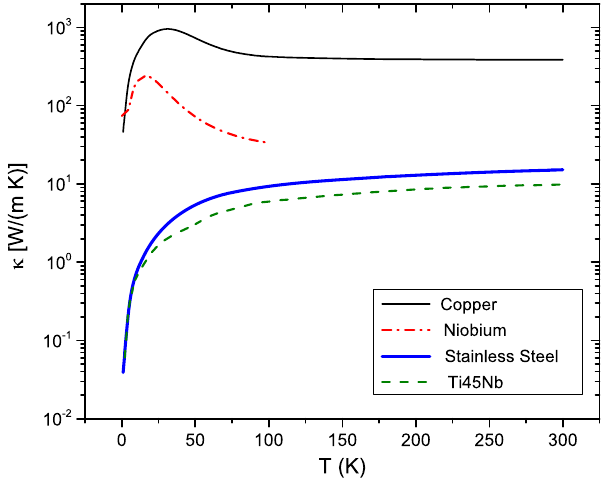
FIG. 11. Temperature-dependent thermal conductivity of the materials used in the thermal analysis.